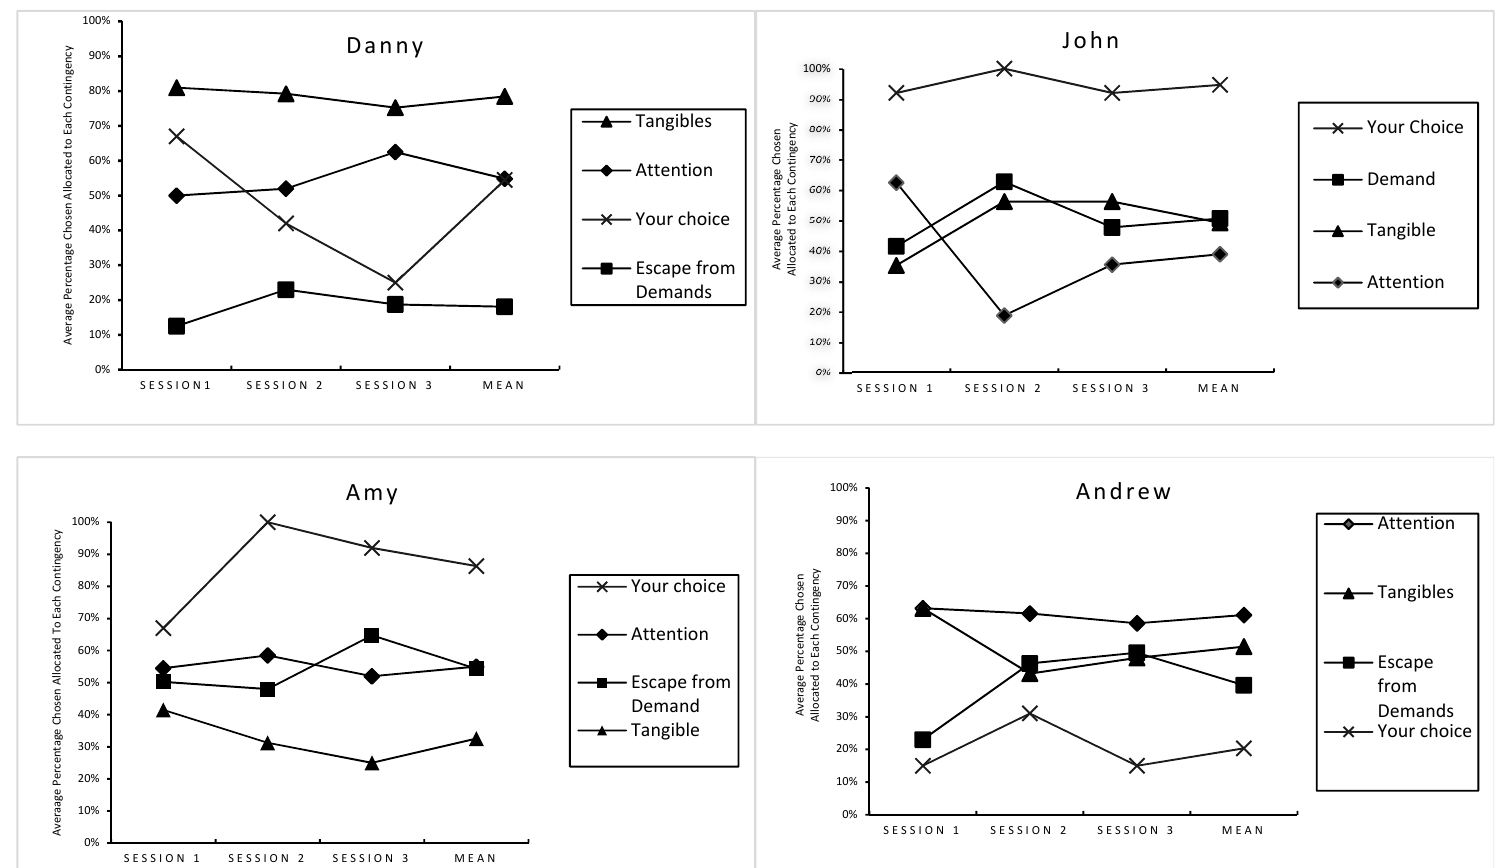
Figure 3. The average percentage chosen allocated to each category of the social contingency for each participant.